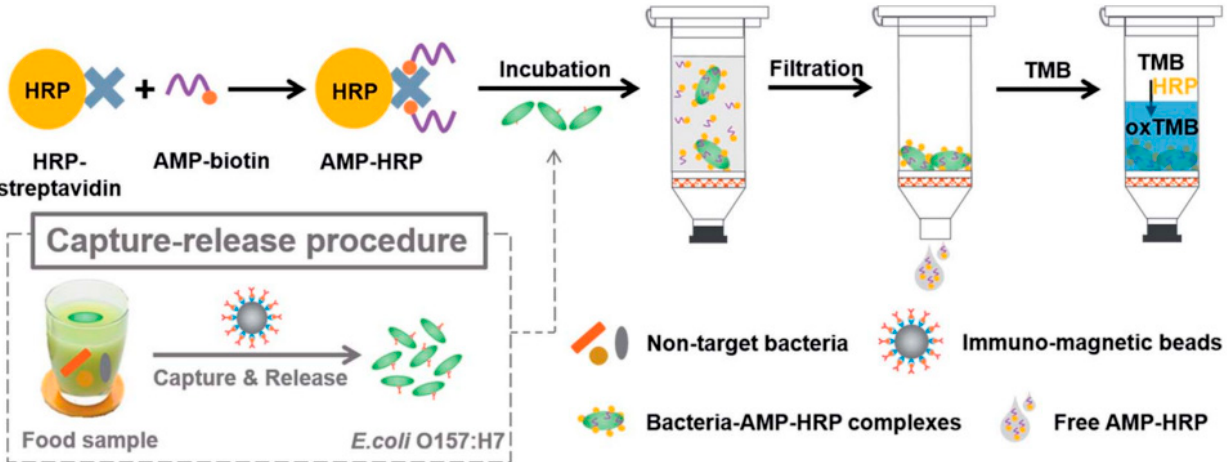
Figure 11. Schematic illustration of the AMP-based colorimetric bioassay for the detection of E. coli O157:H7 [130]. Copyright 2017, Royal Society of Chemistry.